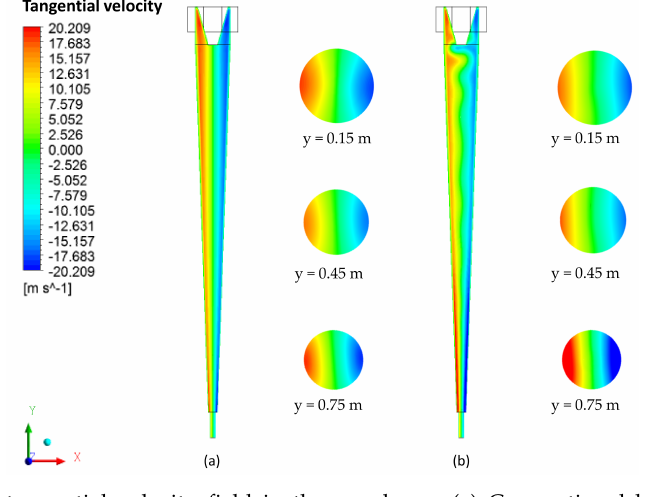
Figure 7. Water tangential velocity field in the yz plane. ( a ) Conventional hydrocyclone and ( b ) filtering hydrocyclone.